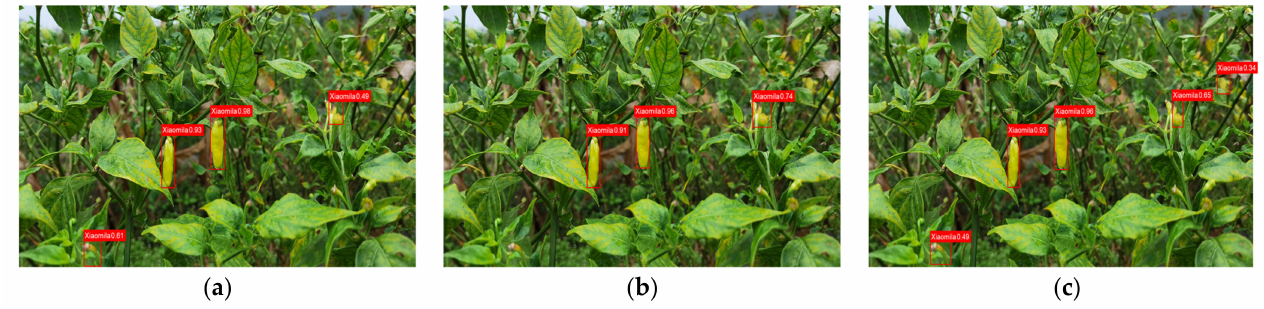
Figure 15. Comparison of the detection results of different models when size and color of the fruit and the leaf are similar. ( a ) YOLOv5s-CFL detected small targets but mistakenly detected pedicel as the target; ( b ) YOLOv5s missed part of small targets and mistakenly detected pedicel as the target; ( c ) YOLOv3-tiny mistakenly detected leaf and pedicel as the target.